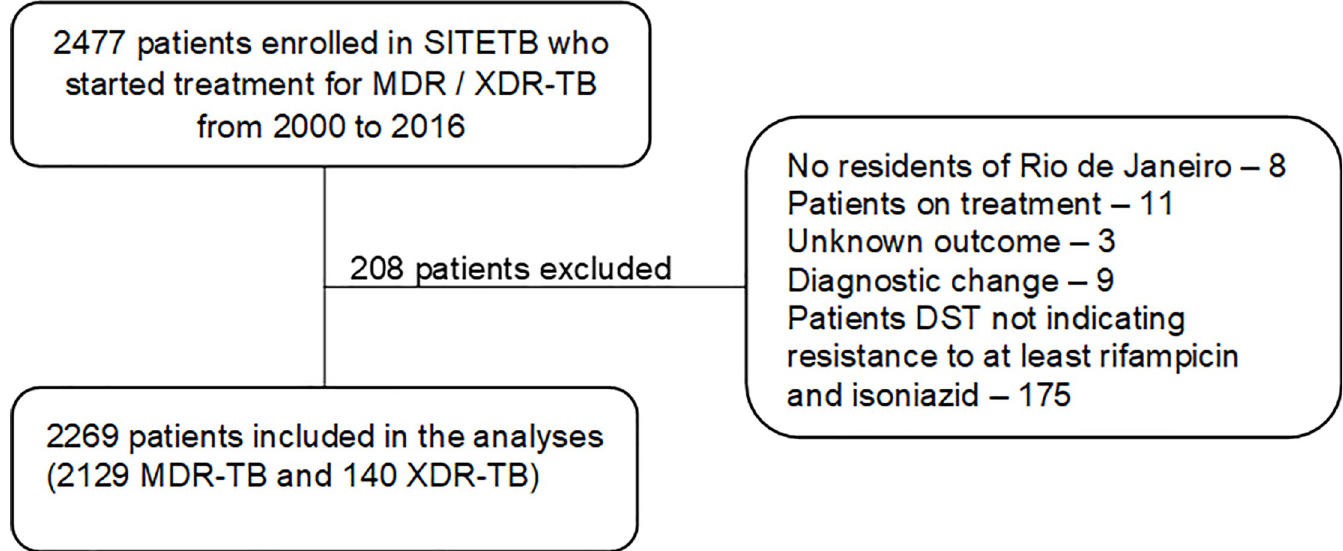
Fig 1. Flowchart of the study’s population. MDR-TB = multidrug-resistant TB; XDR-TB = extensively drug-resistant TB; SITETB = Special Tuberculosis Treatment System; DST = drug-susceptibility testing.